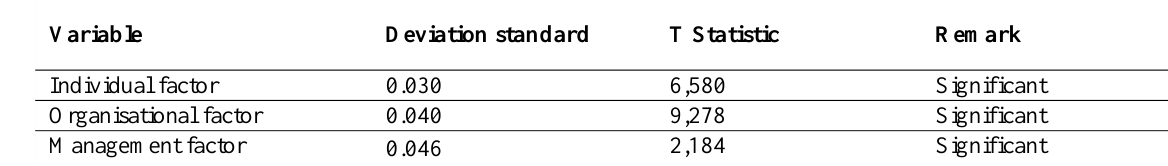
Table 5. Hypothesis value of the variables of the individual factors, organisational factors and management factor on the prevention of Ulcus Decubitus based on Six Sigma